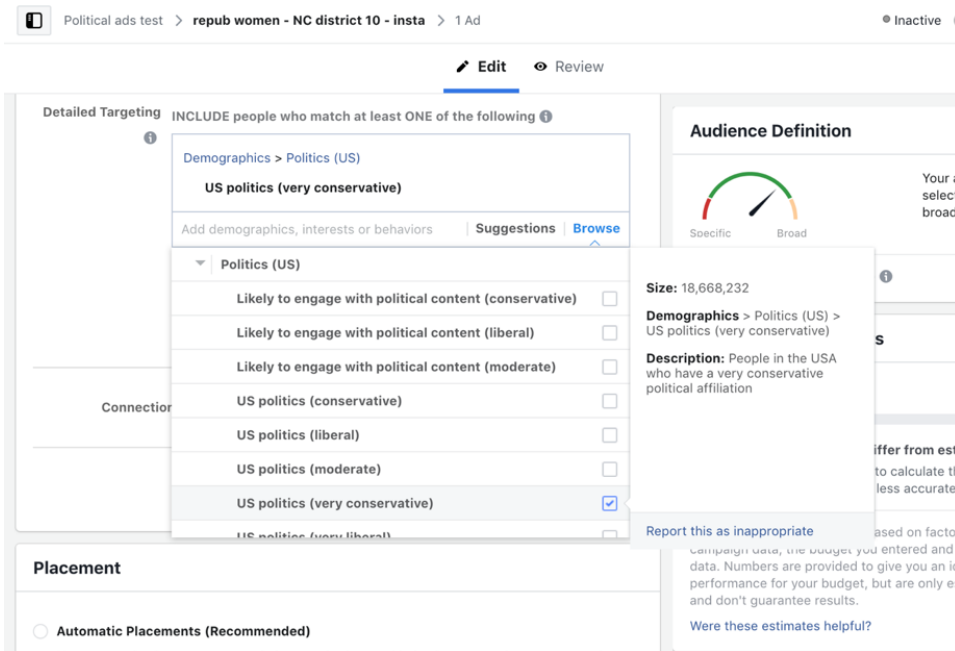
Figure 11: Screenshot from the Facebook ad buying interface, 16 January